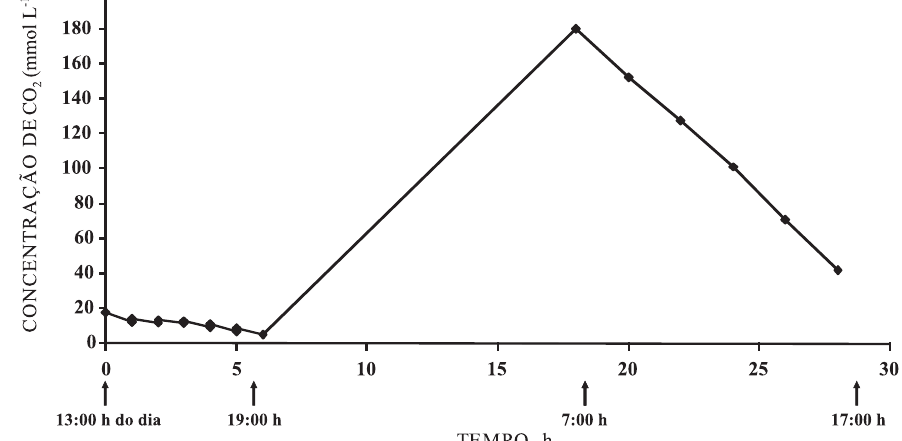
Figura 2. Concentrações de CO na câmara ao longo do tempo de marcação. As setas pretas mostram a hora 2 do dia ao longo do processo de marcação. Os pequenos picos sucessivos mostram o momento da adição do carbonato de sódio com 99 % em átomo de 13 C. Em detalhe, a modificação na escala para mostrar as diferenças de concentração de CO antes e após cada pulso nas primeiras seis horas de marcação do 2